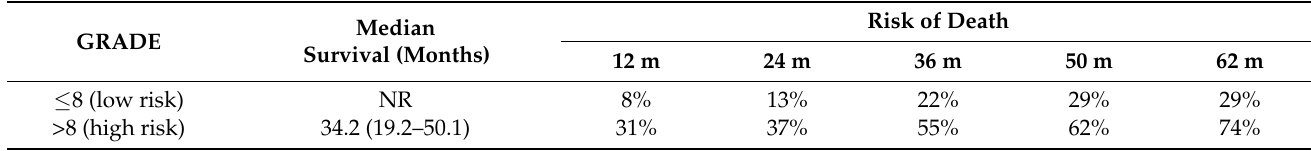
Table 3. 5-year risk of death according to the pre-operative GRADE score among older patients undergoing major cancer